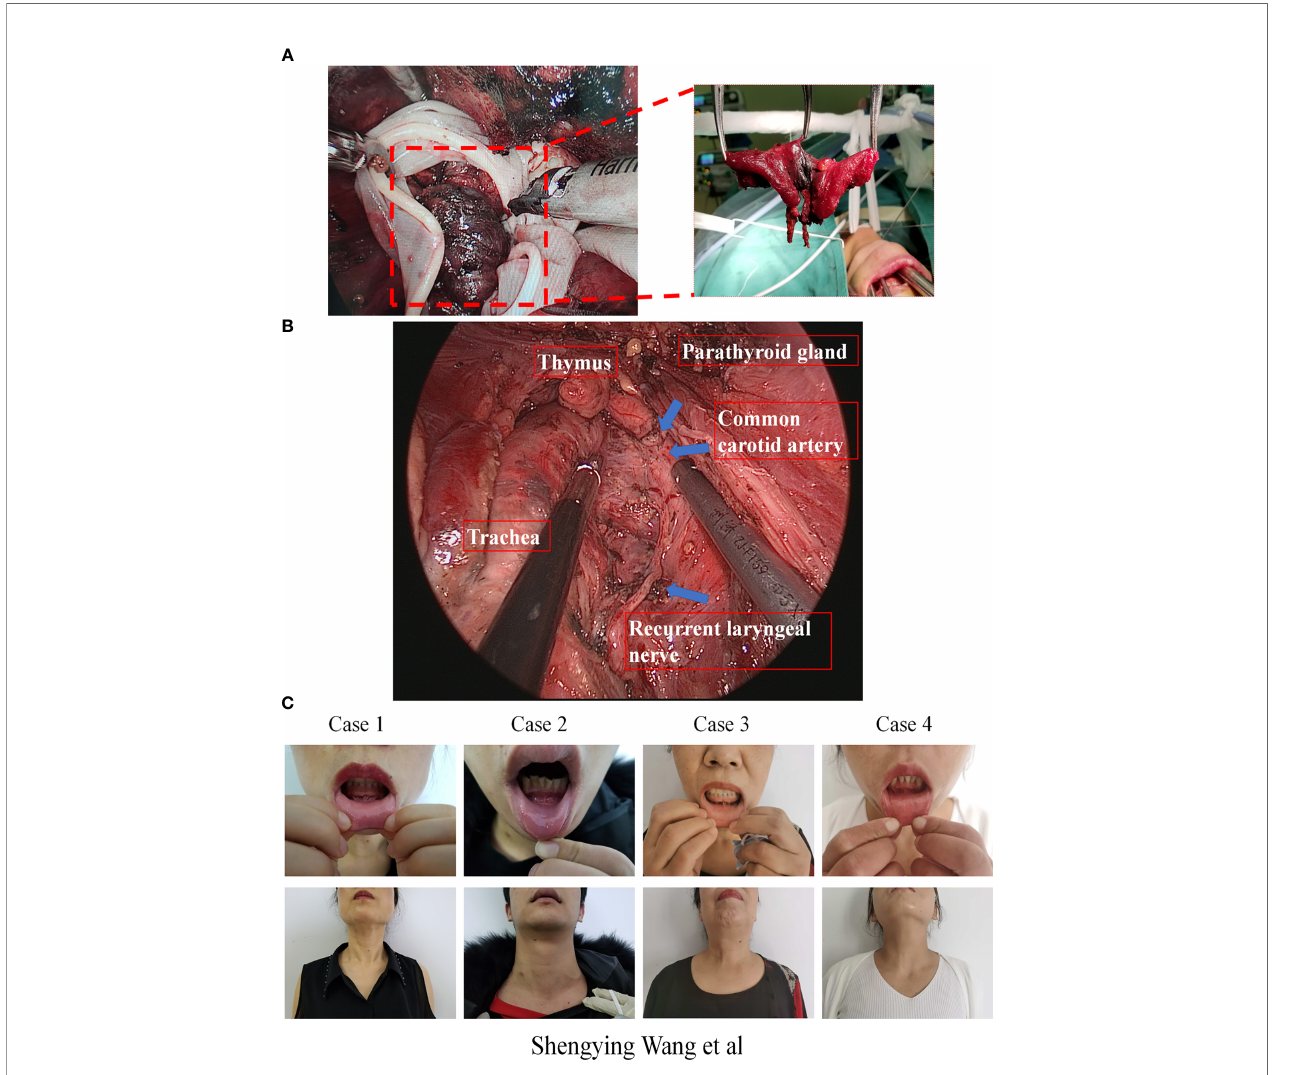
FIGURE 2 | (A) The en bloc resected thyroid tissue and central lymph nodes are put into a special specimen retrieval bag and then moved outside the body through the observation incision. (B) Important organs view after the specimen resection during gasless TOETVA. (C) Patients ’ front view of oral vestibule incisions and neck